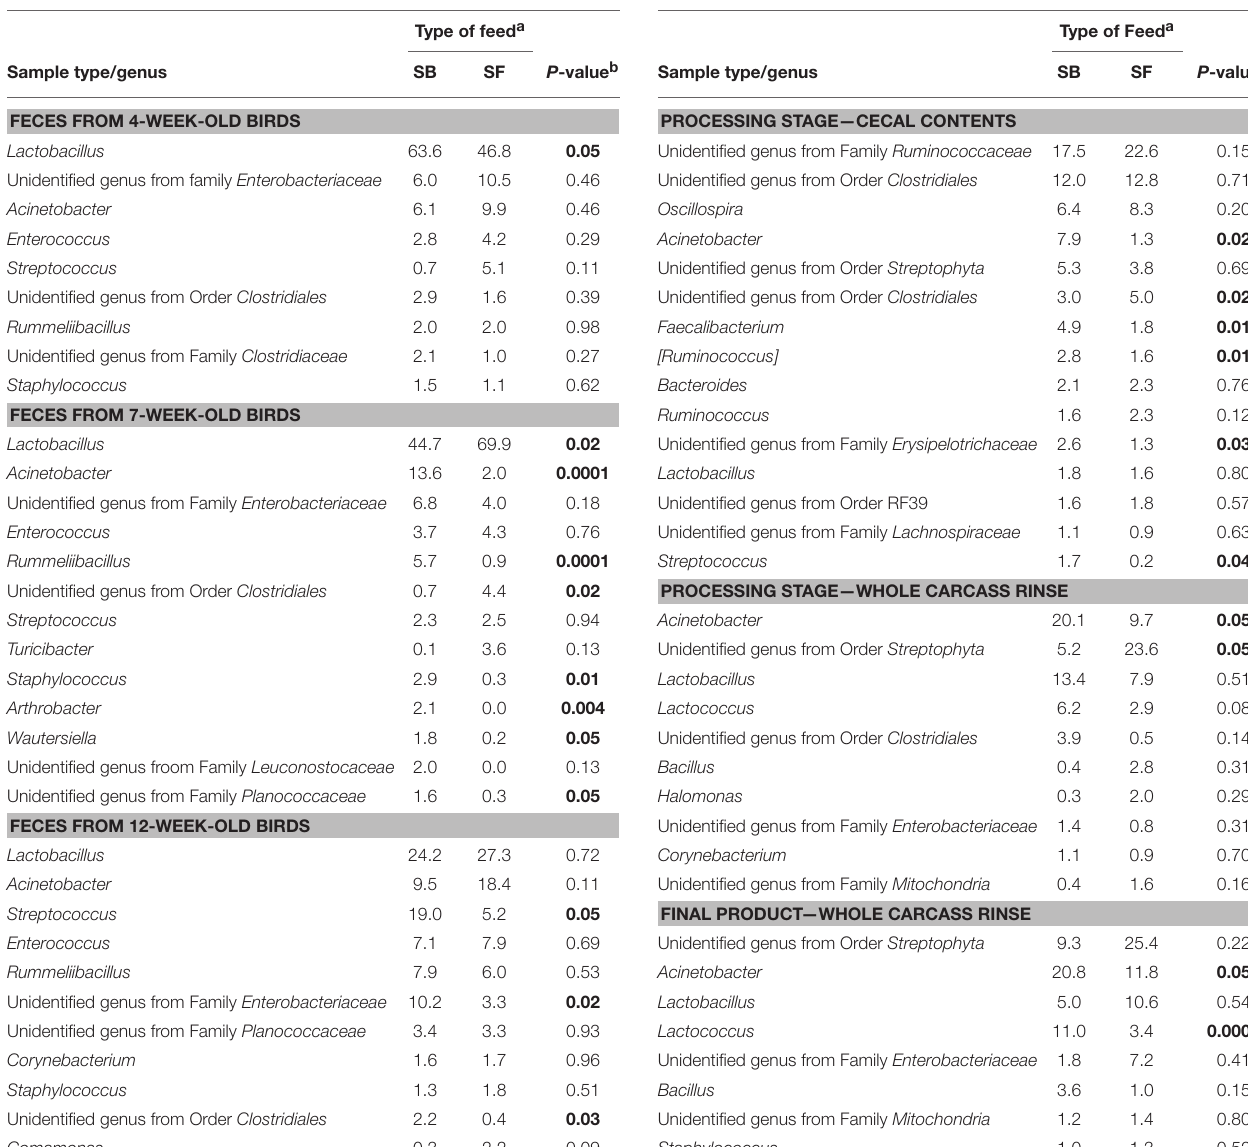
TABLE 4 | Relative abundance of major bacterial genera ( ≥ 1% of all OTUs recovered) for pasture-raised broilers fed soybean or soy-free diets at different stages along the farm-to-fork continuum: cecal contents and whole carcass